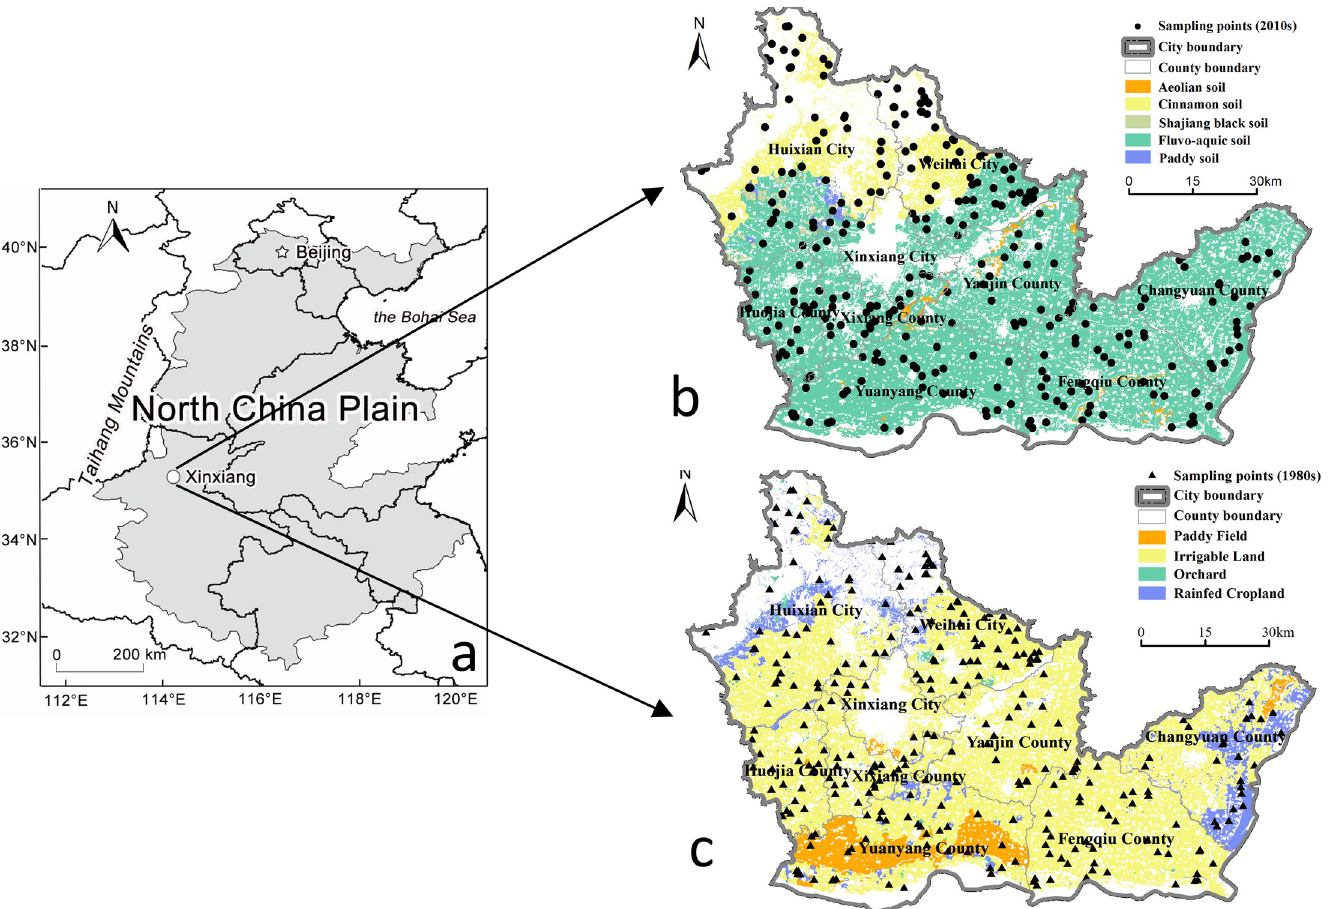
Fig 1. The study area and distribution of sampling sites. a. Location of the study area. b. Distribution of sampling sites in the 1980s and soil types. c. Distribution of sampling sites in the 2010s and agricultural land-use types.